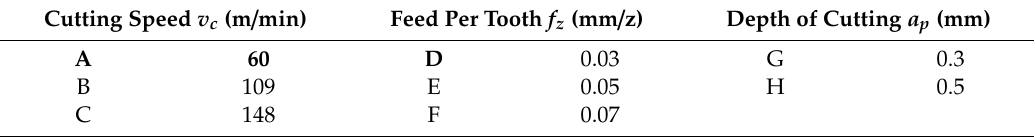
Table 3. Cutting parameters for face milling